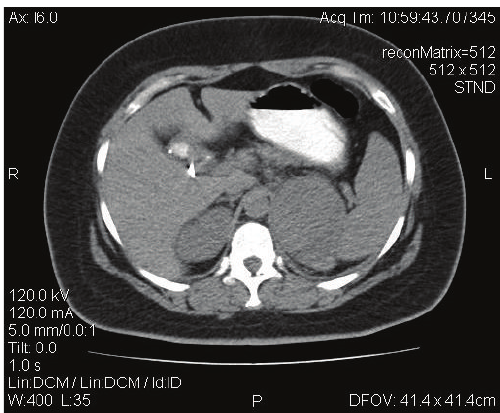
Figure 1: A CT scan image showing the adrenal tumor.